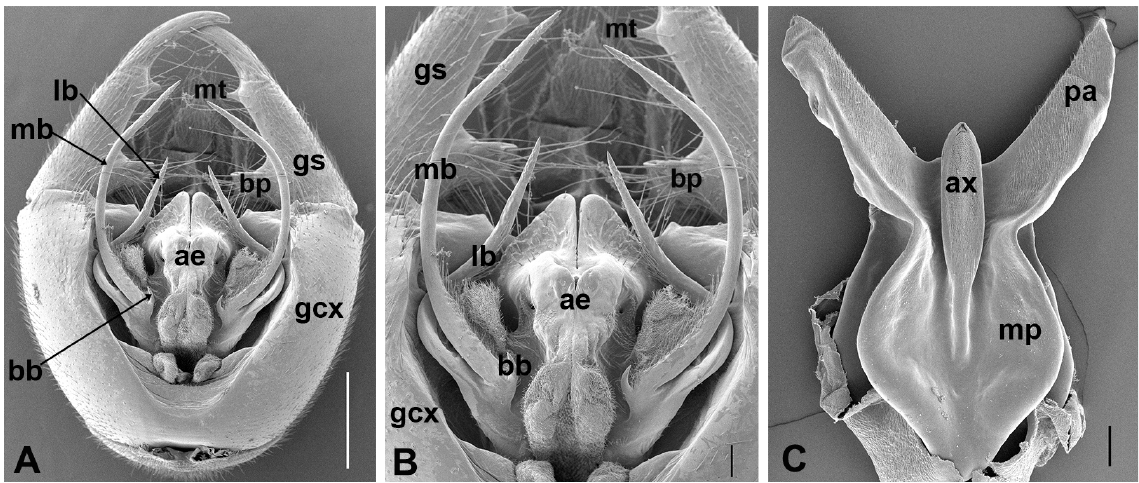
Fig. 5. Scanning electron micrographs of genitalia of Dicerapanorpa zhengkuni sp. nov. A . ♂, genitalia in ventral view, with hypandrium removed. B . Magnification of A. C . ♀, medigynium, ventral view. Scale bars: A = 0.5 mm; B–C = 0.1